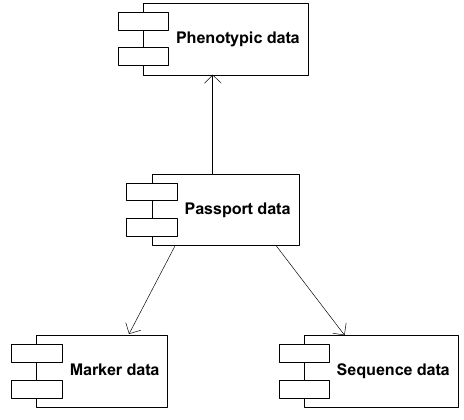
Figure 1: Linkage of data from different